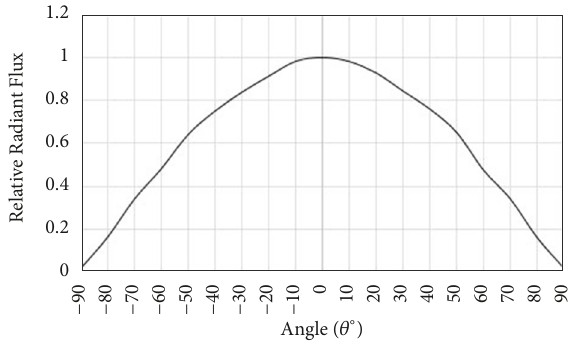
Figure 10: Relative radiant flux distribution of the